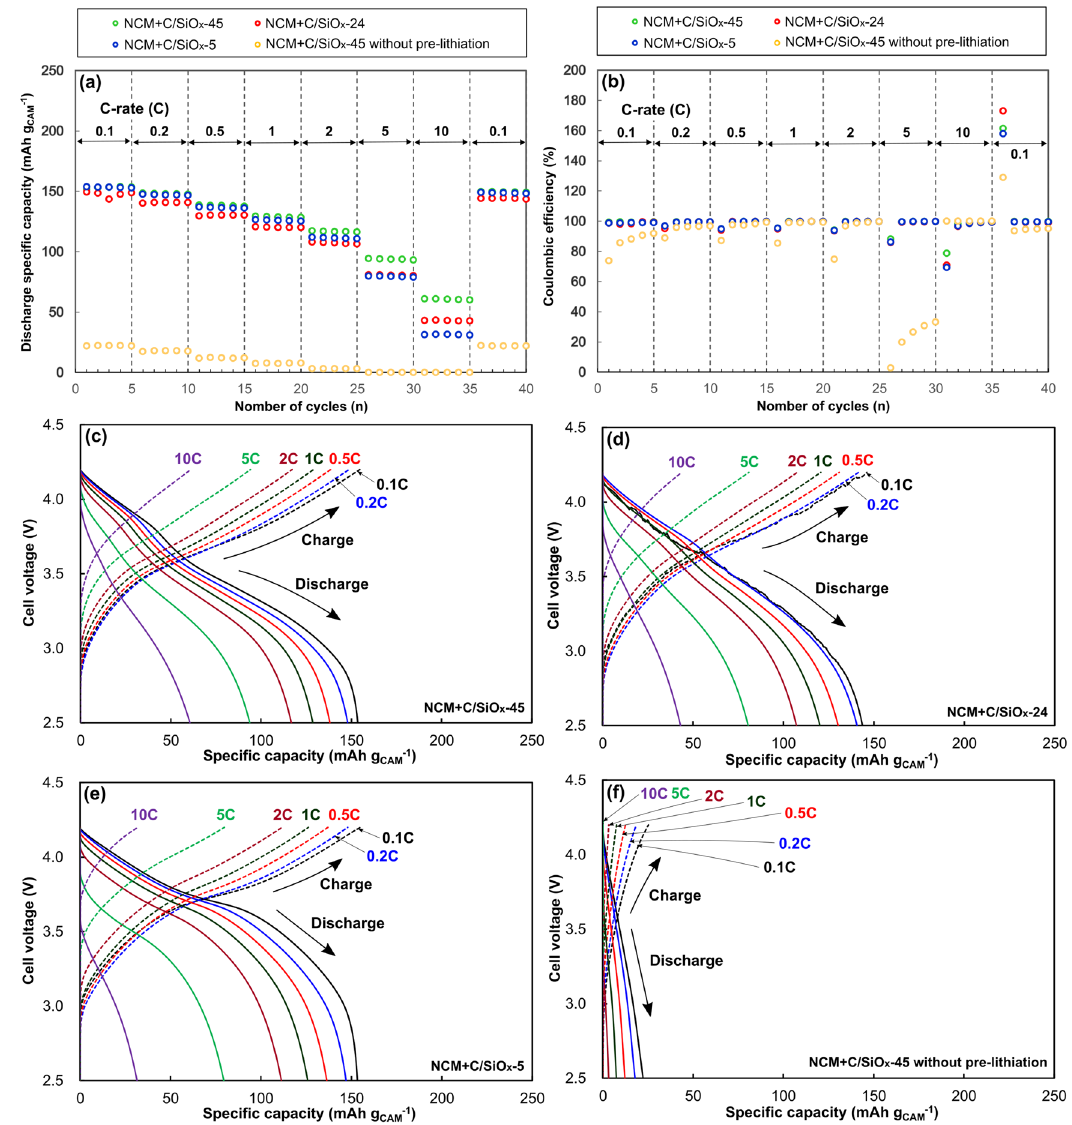
Figure 4. Rate performance of the Li(Ni 0.5 Co 0.2 Mn 0.3 )O 2 (NCM) + C/SiO x full-cells. ( a ) Discharge specific capacity and ( b ) Coulombic efficiency at different C-rates. Cell voltage-specific capacity profiles of the